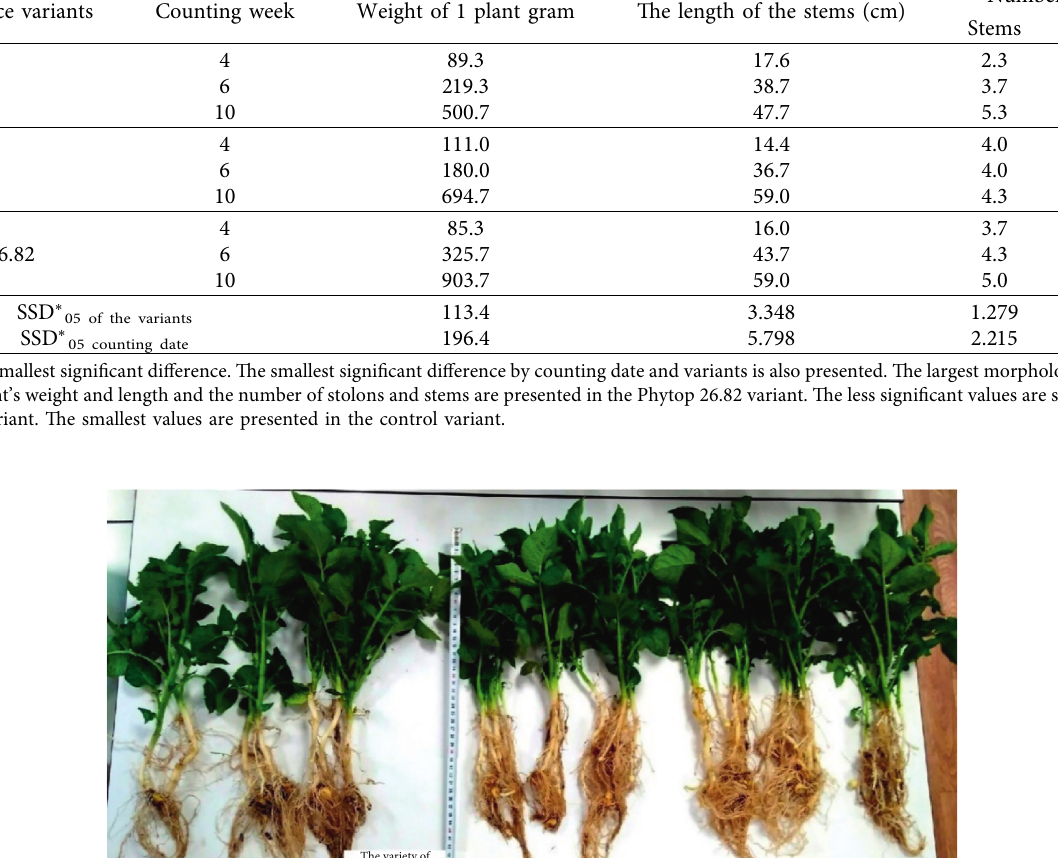
Number, pieces Stems